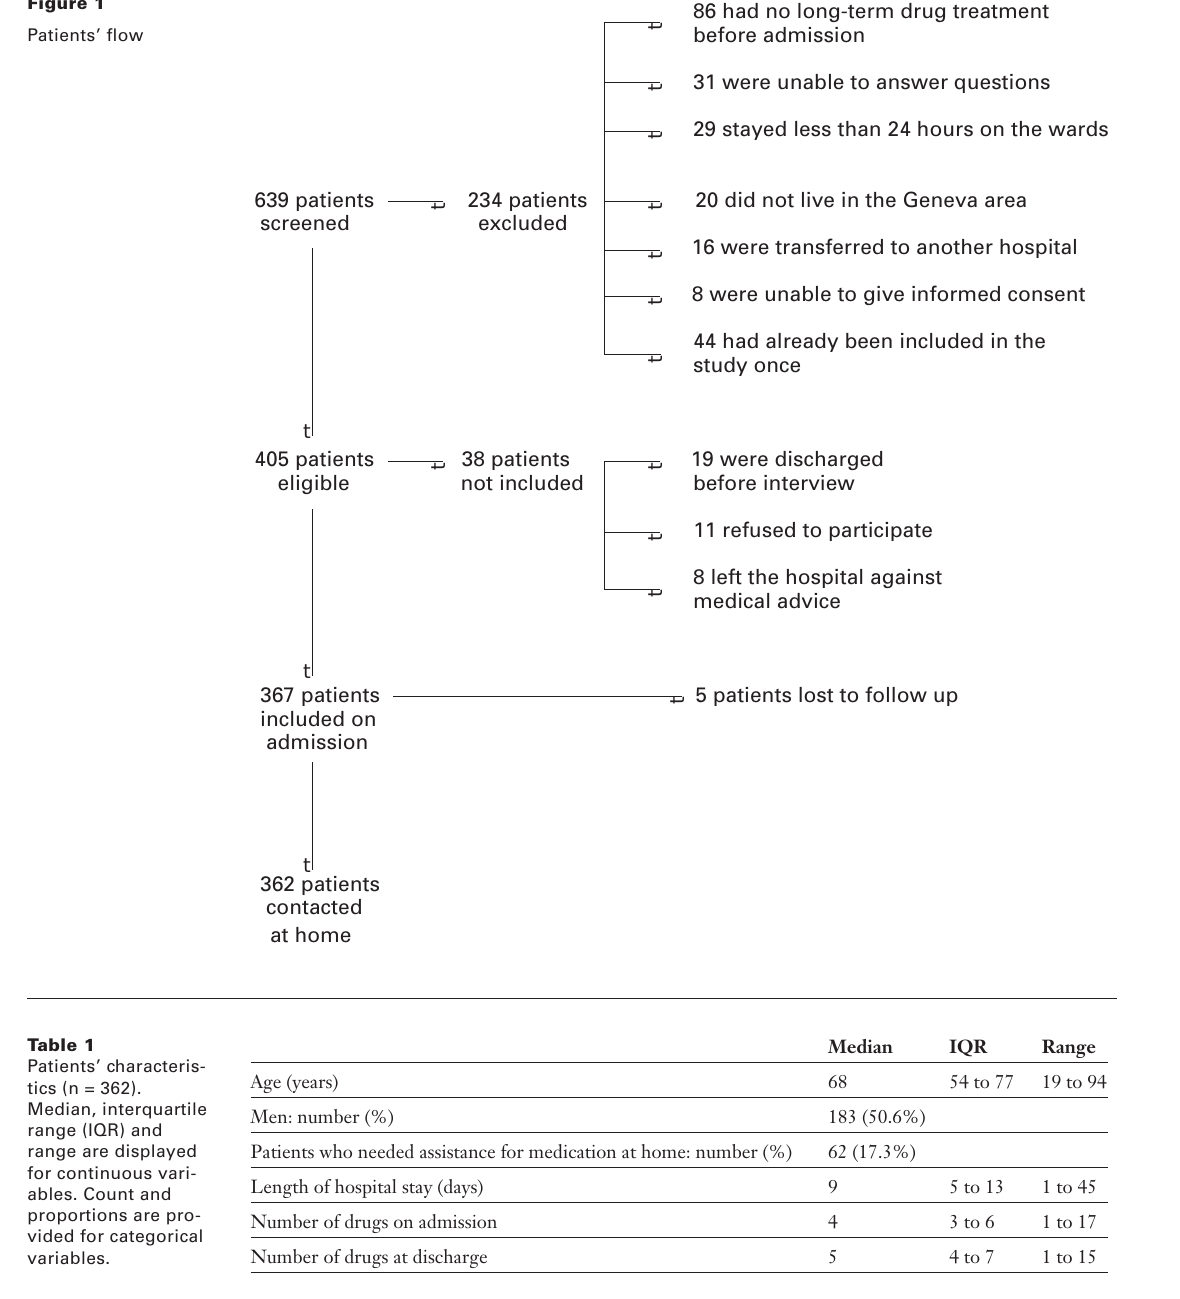
Figure 1 Patients’ flow